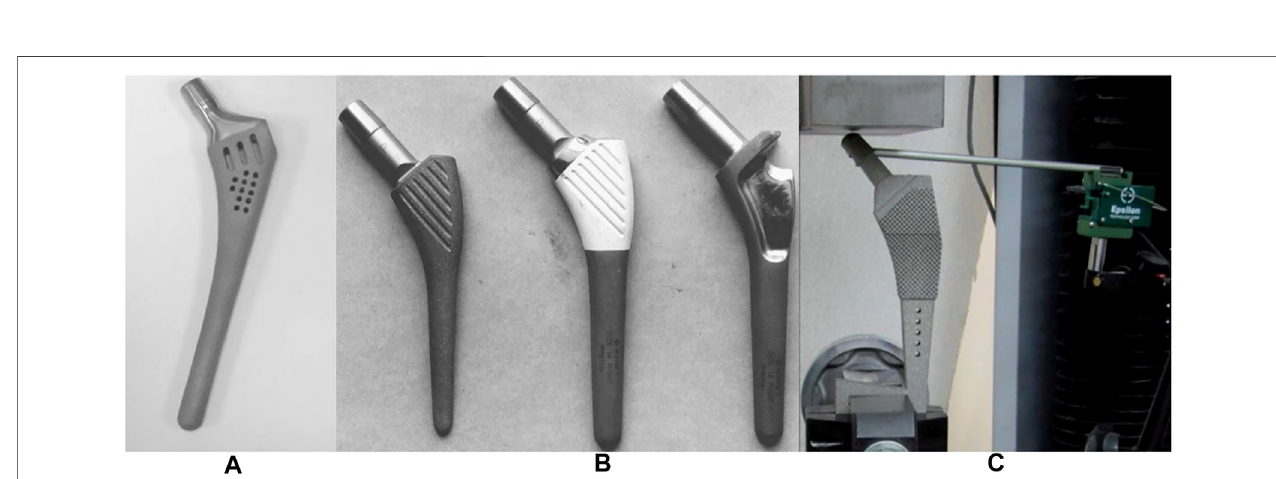
FIGURE 10 | (A) hollow femoral stem designed by Yang et al. (2009). (B) cement-locked uncemented (CLU) femoral stem (Viceconti et al., 2001). (C) cementless stem with porous structure for injecting bone cement, designed by Eldesouky et al. (2017b).